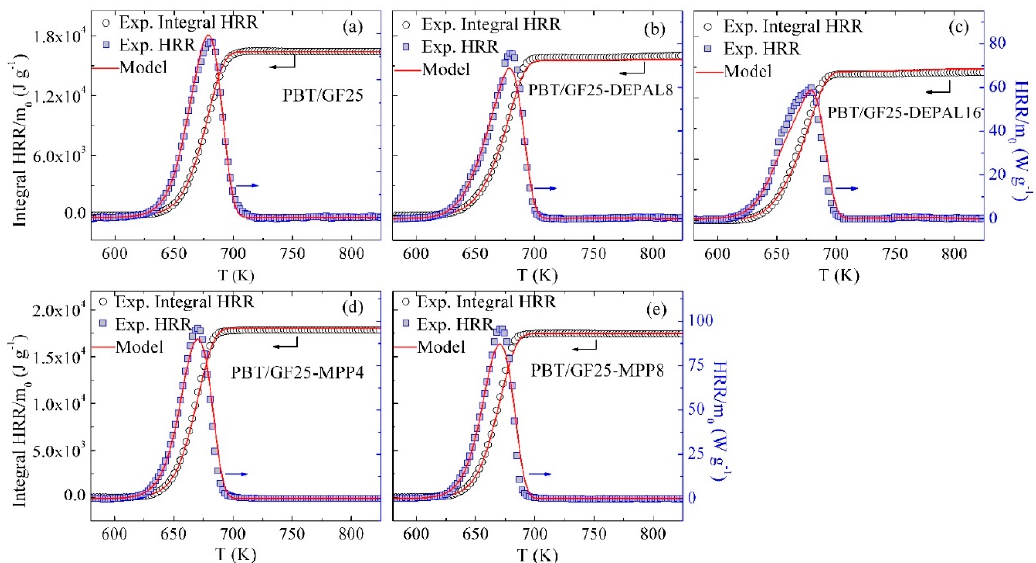
Figure 5. Experimental and simulated Microscale Combustion Calorimetry (MCC) data obtained for ( a ) PBT/GF25, ( b ) PBT/GF25-DEPAL8, ( c ) PBT/GF25-DEPAL16, ( d ) PBT/GF25-MPP4, and ( e ) PBT/GF25-MPP8 at 10 K · min − 1 .